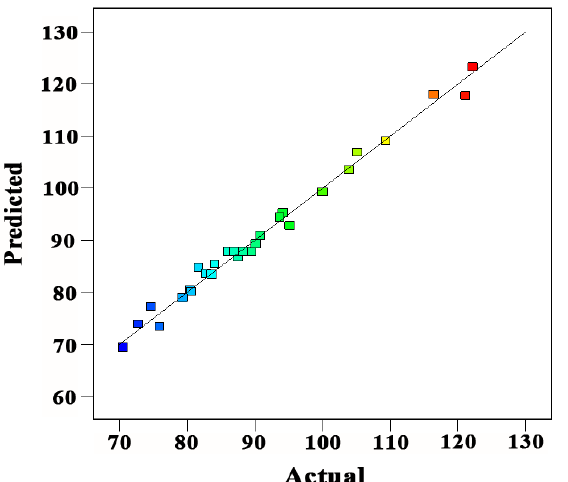
Figure 3. Correlation between the actual and predicted values of extracted yield of proanthocyanidins (PAs) from kiwifruit leaves.